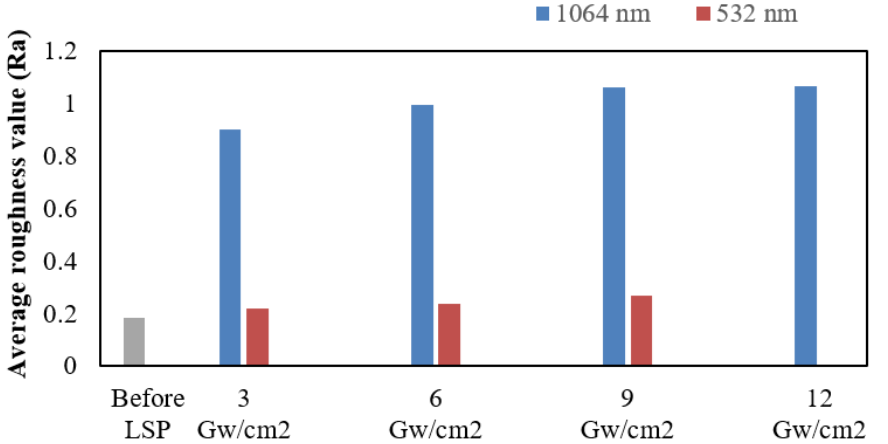
Figure 11. Surface roughness graph of LSPwC specimen with 1064 (blue) nm and 532 nm (red) and before LSP (gray)